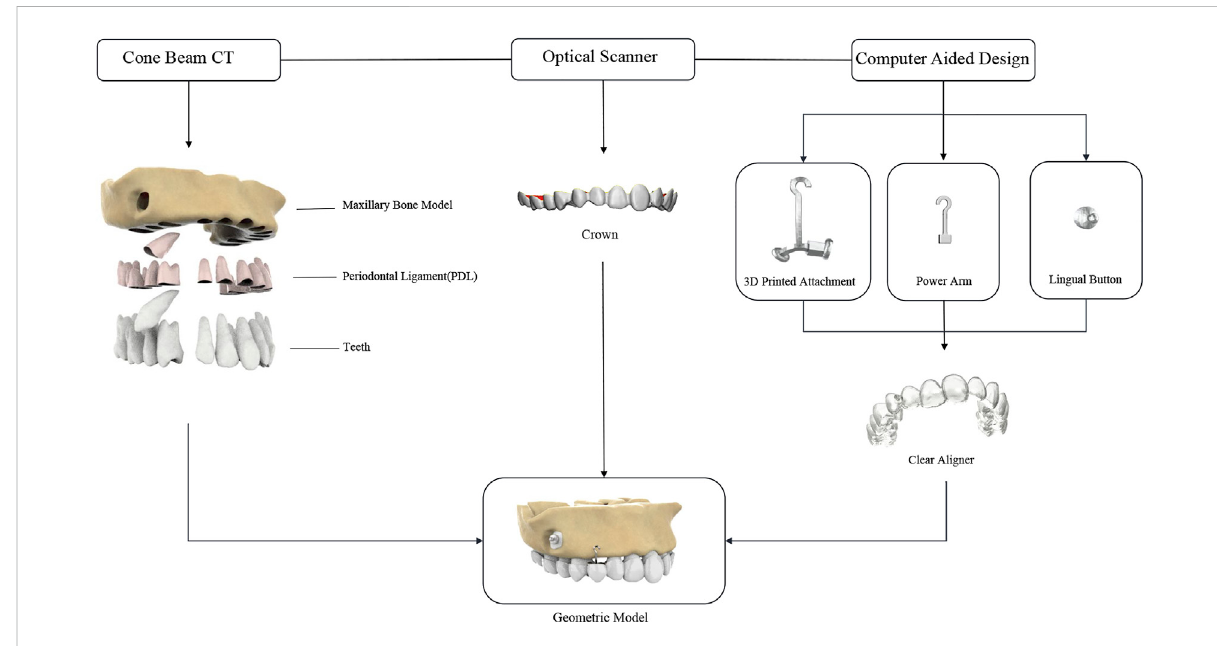
FIGURE 1 Computer-aided design